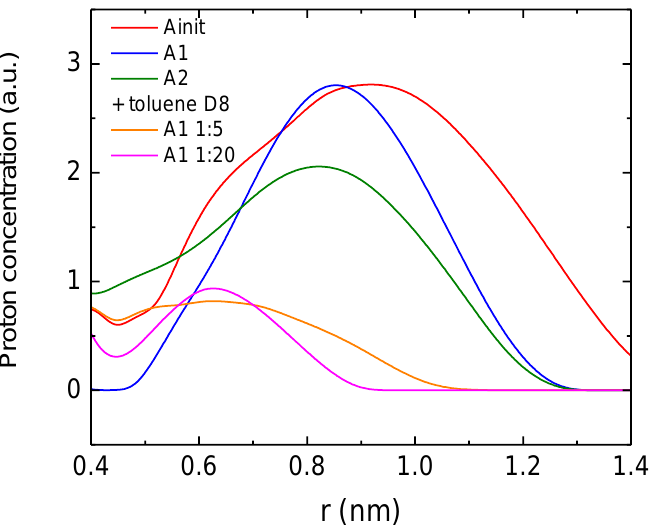
Figure 10. Distribution of proton concentration depending on the distance from the localization site of FR.